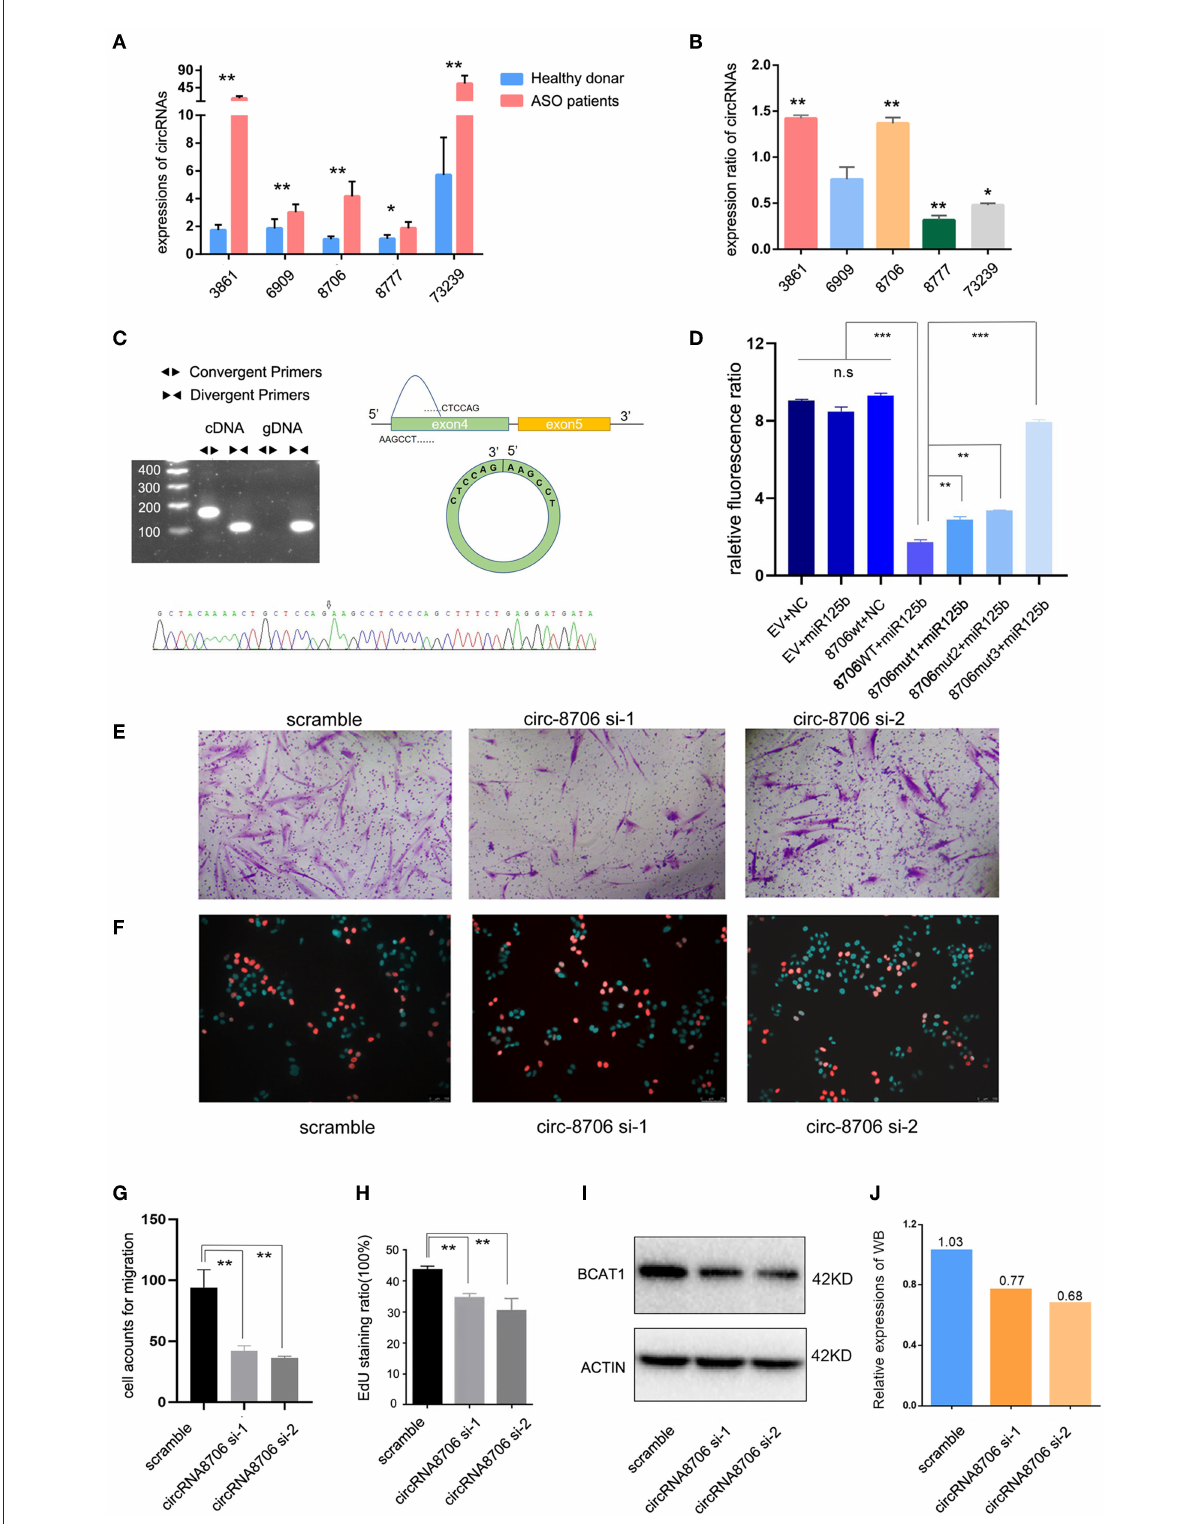
FIGURE5 CircRNA-0008706 promoted vascular smooth muscle cell (VSMC) proliferation and migration. (A) Validation of circRNA expression in the lesions of patients with ASO (8 ASO specimens and 9 donor specimens); (B) Expression ratio of circRNA expression in human arterial smooth muscle cells (HASMCs). The ratio of each circRNA expression after PDGF-bb stimulation/expression without PDGF-bb stimulation; (C) Identification of